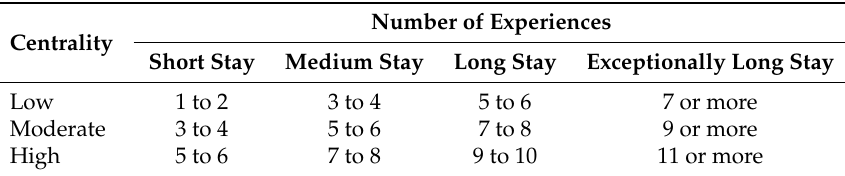
Table 3. Degree of cultural centrality based on number of experiences and duration of